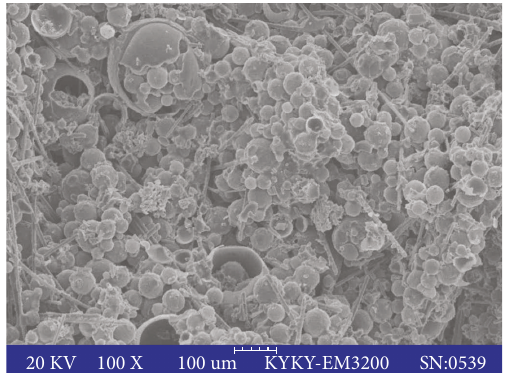
Figure 4: Microstructure image of the original ablative thermal insulation